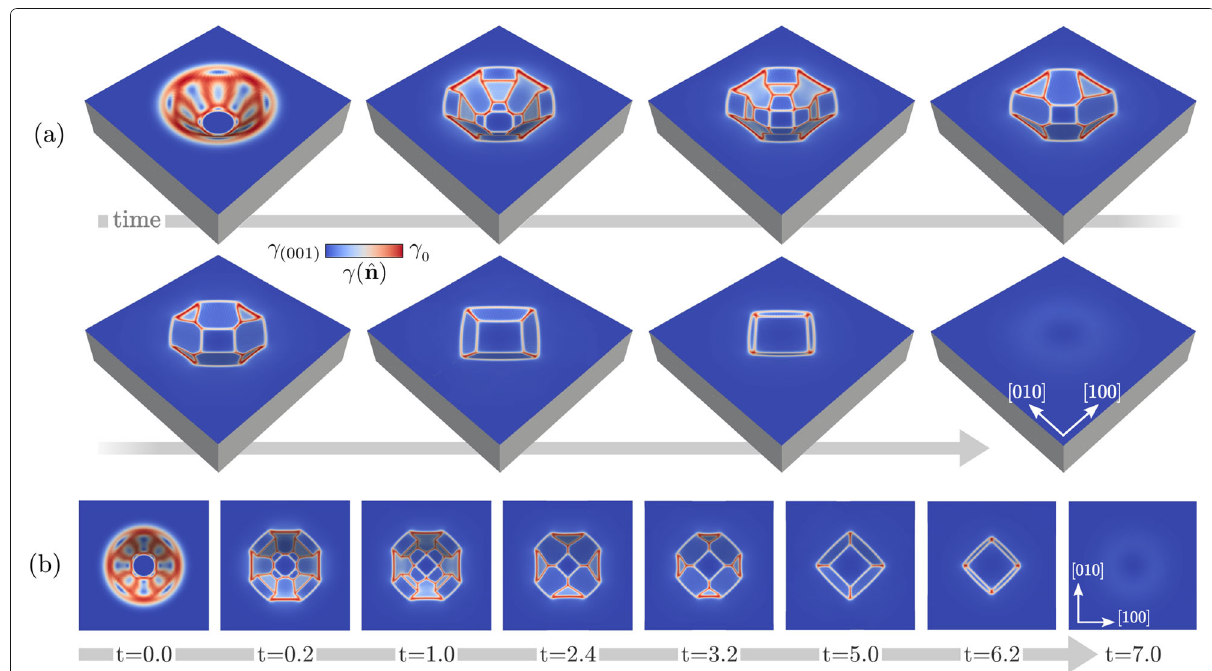
Fig. 3 Evolution towards the equilibrium for a Si pit having an initial morphology as in Fig. 2b. a Perspective view showing the main morphological changes. b Top view of the morphologies in panel a . The time reported in panel b is expressed in arbitrary units. The color scale shows the values of γ( ˆ n ) at the surface